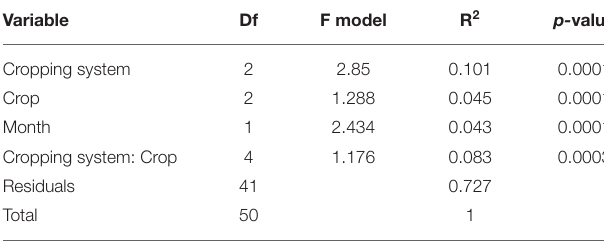
TABLE 3 | PERMANOVA of the effects of cropping system, crop, month, and the interaction between cropping system and crop on soil bacterial communities. Variable